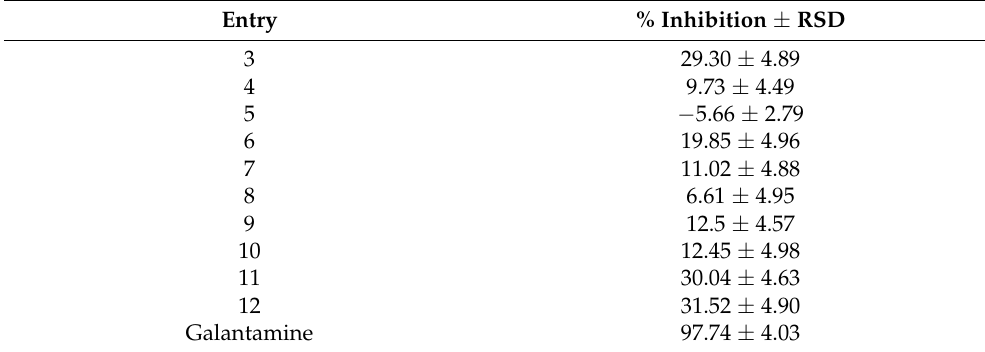
Table 5. Effect of the synthesized compounds acting as acetylcholinesterase inhibitors at 100 µ